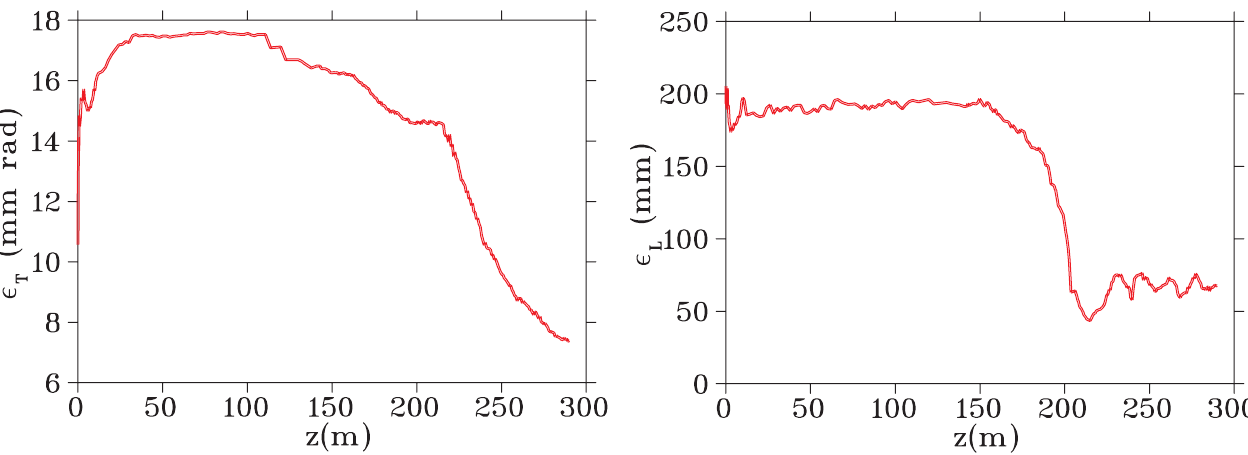
FIG. 13. (Color) Longitudinal phase space at the end of the channel. Right: the vertical scale expands from 0 to 400 MeV =c with 100 bins; the horizontal scale is from 20 to 60 m with 100